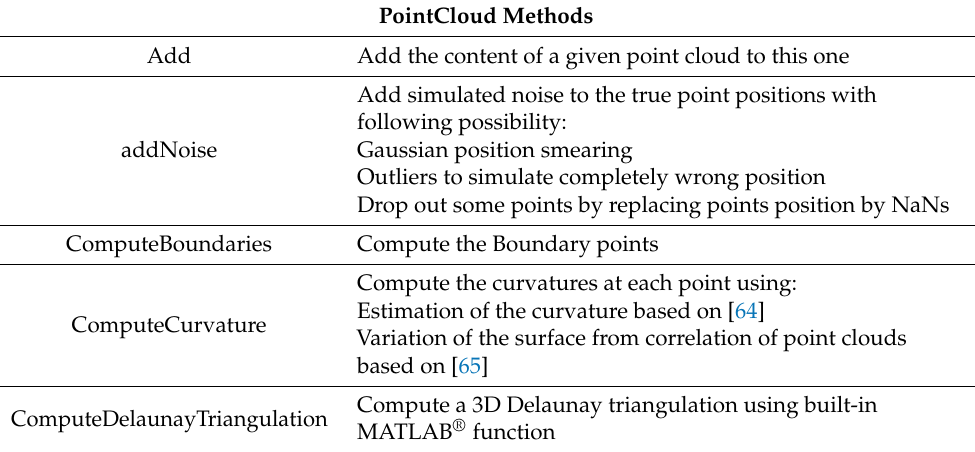
Table A3. PointCloud methods or functions implemented to operate on PointCloud objects